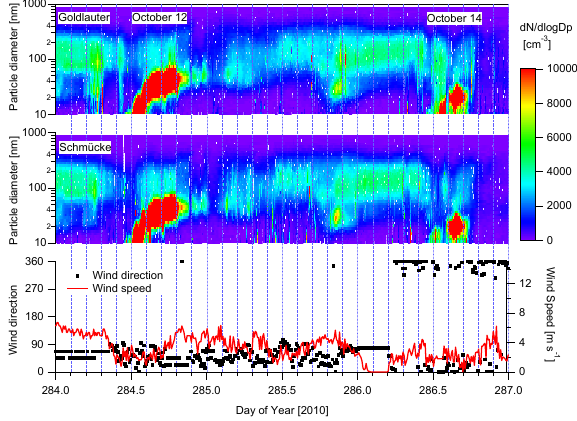
Fig. 1: The evolution of particle number size distribution and weather conditions on 703 Fig. 1. The evolution of particle number size distribution and weather conditions on 12 and 14 October 2010.